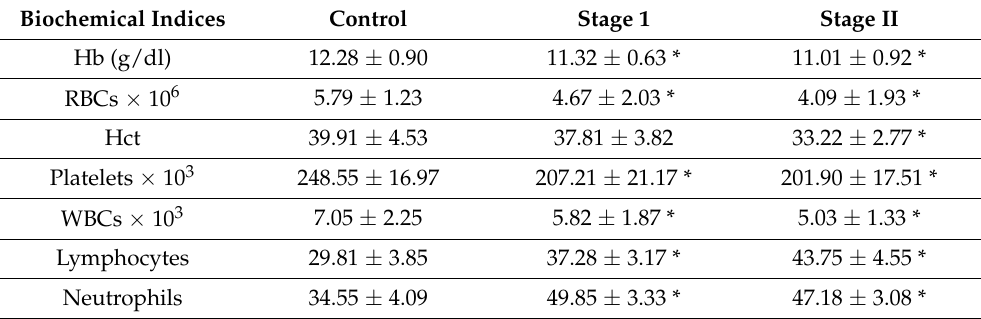
Table 3. Mean ± SD of CBC indices in all studied groups (control, stage I and stage II). Biochemical Indices